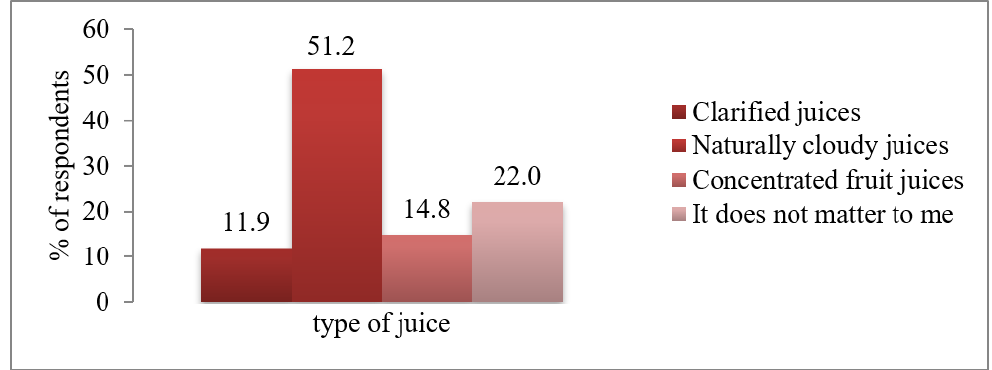
Figure 6. Respondents’ preferences for choosing citrus juices due to texture. A large proportion of respondents did not pay attention to the form of juice preparation. For 44% of respondents, it does not matter whether the juice is pasteurised or unpasteurised. Of the respondents, 36.8% chose unpasteurised juices, and 19.3% chose pasteurised juices (see Figure 7).